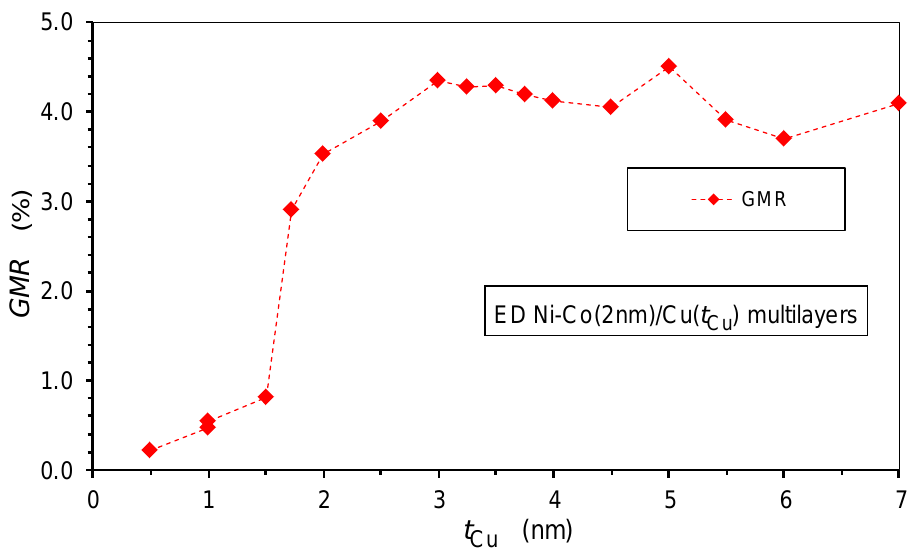
Figure 13. Evolution of the magnitude of the GMR effect with spacer layer thickness t Cu for the present Ni65Co35/Cu multilayers.